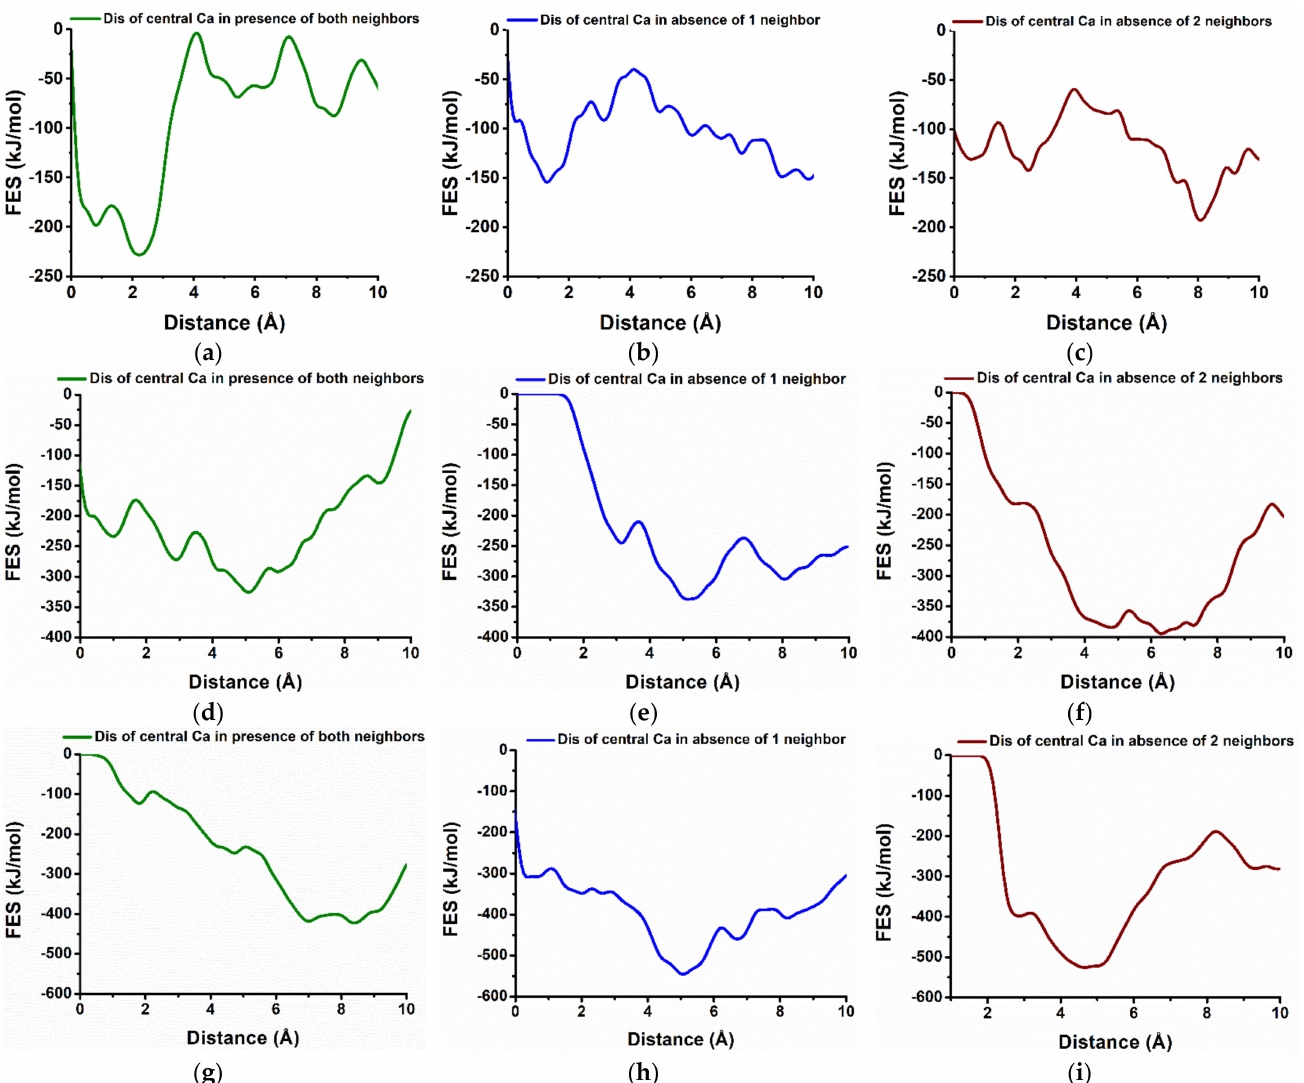
Figure 5. Characteristic dissolution profile (free energy surface) of the central Ca (violet Ca in the Figure 2) ( a – c ), from (100); ( d – f ); from (110); and ( g – i ); from (010); crystalline facets of Portlandite in the different scenarios: before and after removal of one and two